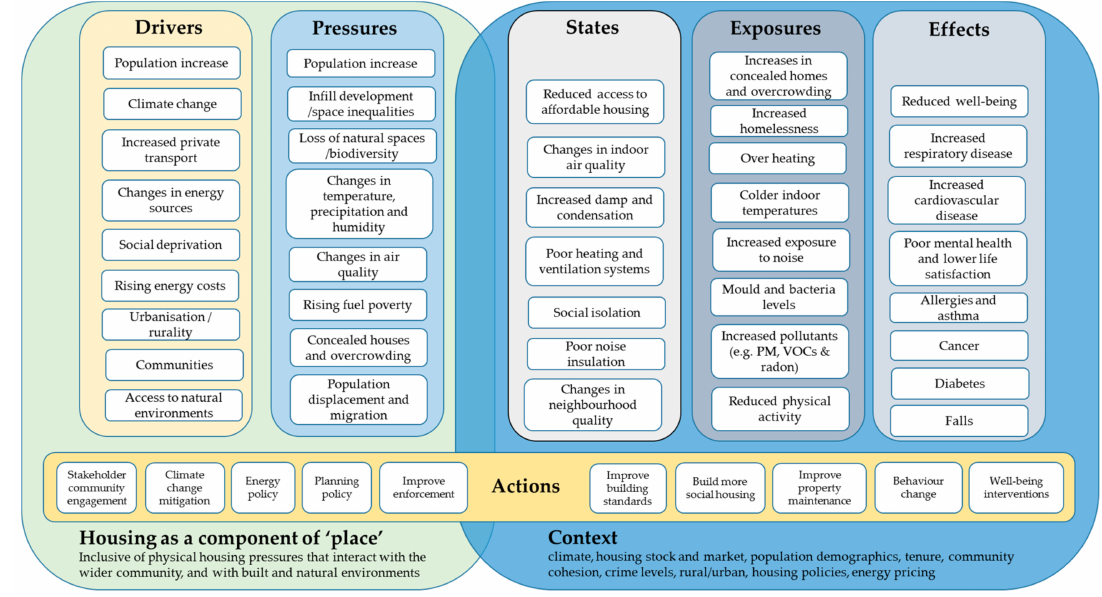
Figure 1. Health and housing conceptual framework using a modified DPSEEA model